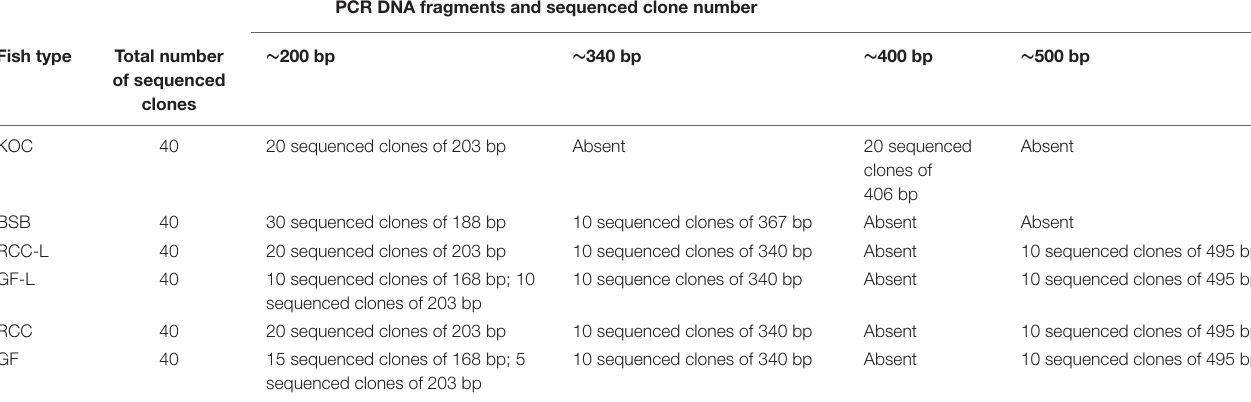
FIGURE 5 | DNA bands (5S rDNA) amplified by the primer pair 5SF-5SR in BSB, KOC, RCC-L, RCC, GF, and GF-L. Lane 1, two DNA fragments (approximately 200 and 360 bp) found in BSB. Lane 2, two DNA fragments (approximately 200 and 400 bp) found in KOC. Lane 3, three DNA fragments (approximately 200, 340, and 500 bp) found in RCC-L. Lane 4, three DNA fragments (approximately 200, 340, and 500 bp) found in RCC. Lane 5, four DNA fragments (approximately 160, 200, 340, and 500 bp) found in GF-L. Lane 6, four DNA fragments (approximately 160, 200, 340, and 500 bp) found in GF. M represents DNA ladder markers (100 bp increments). TABLE 3 | Results of 5S rDNA DNA fragments by PCR and sequenced clone number. PCR DNA fragments and sequenced clone